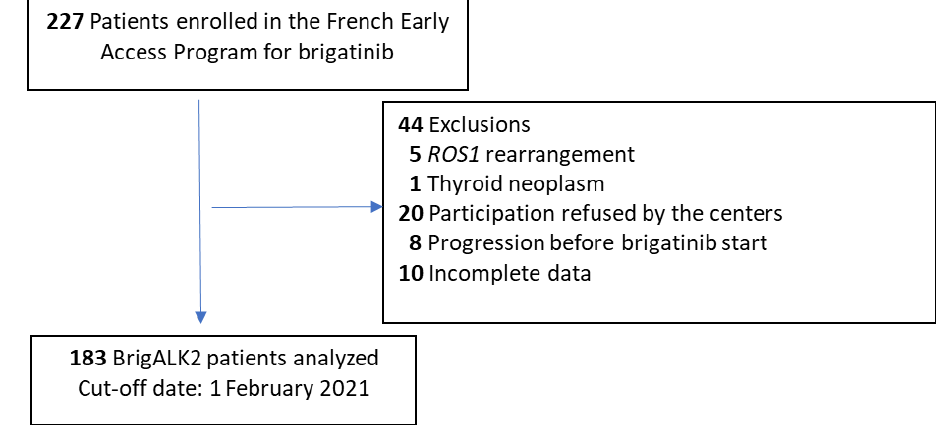
Figure 1. Study flow-chart.